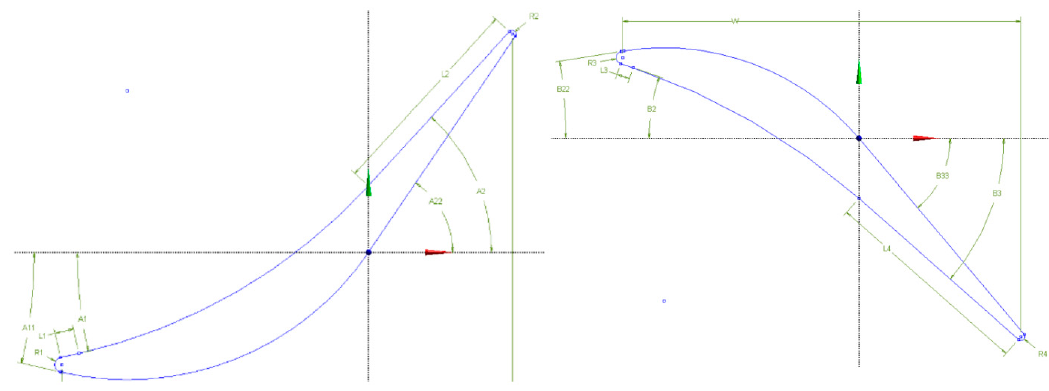
Figure 2. Stator ( left ) and Rotor ( right ) blade profiles with calculated angles.